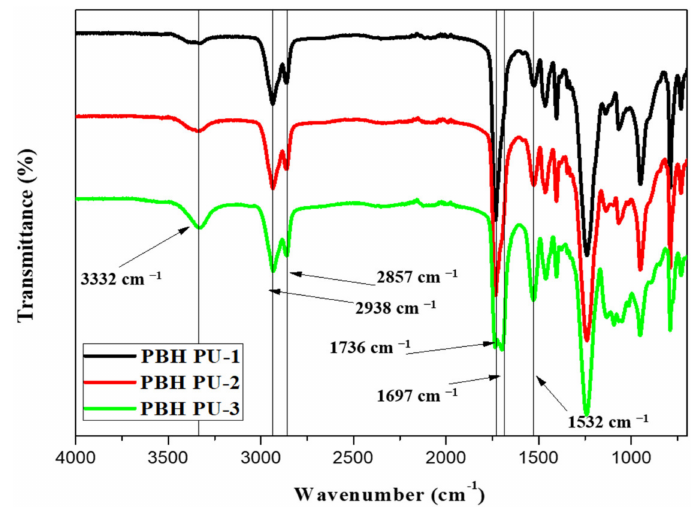
Figure 5. FT-IR spectra data of polyurethanes.